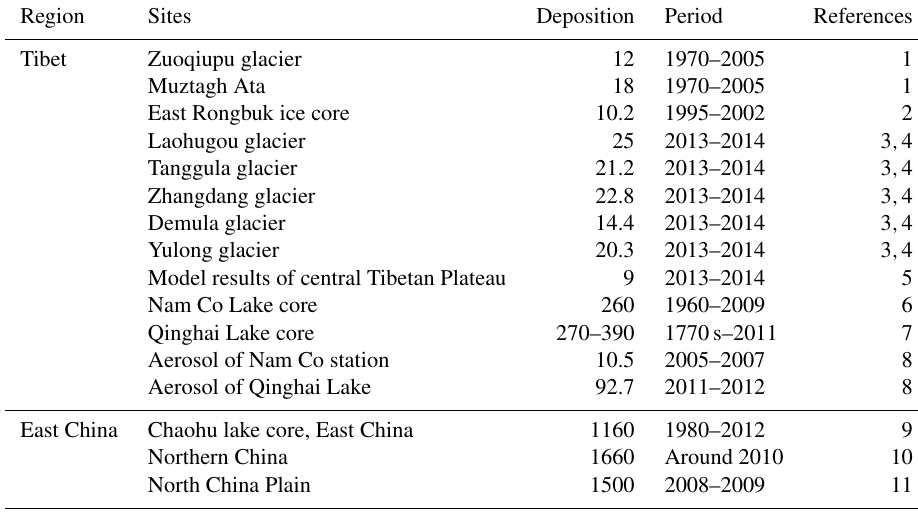
Table 1. Monitored or recovered BC deposition (mgm − 2 a − 1 ) from the HTP and other regions of the world. Region Sites Deposition Period Tibet Zuoqiupu glacier